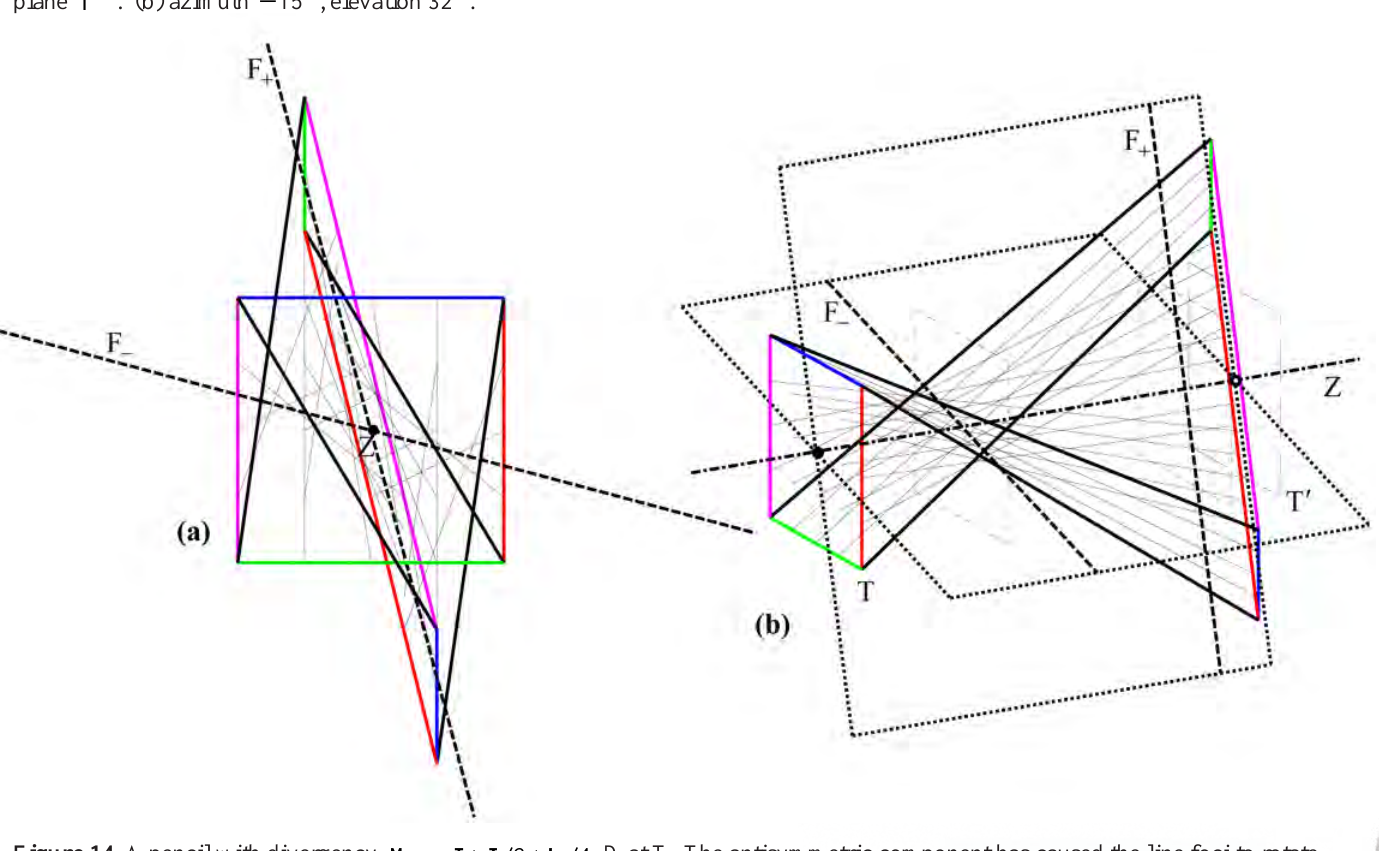
Figure 14 A pencil with divergency 4/2/ LJIM ++−= D at T. The antisymmetric component has caused the line foci to rotate and the focal planes to move towards each other. (b) azimuth °− 20 29 °− 20 , elevation 18 °− 20